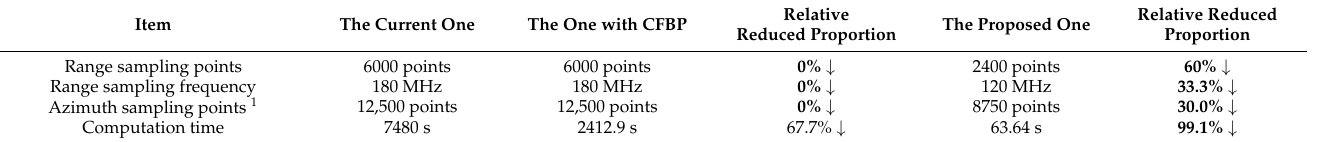
Figure 17. Detection imaging result of the proposed framework. Table 5. Comparison results for the typical